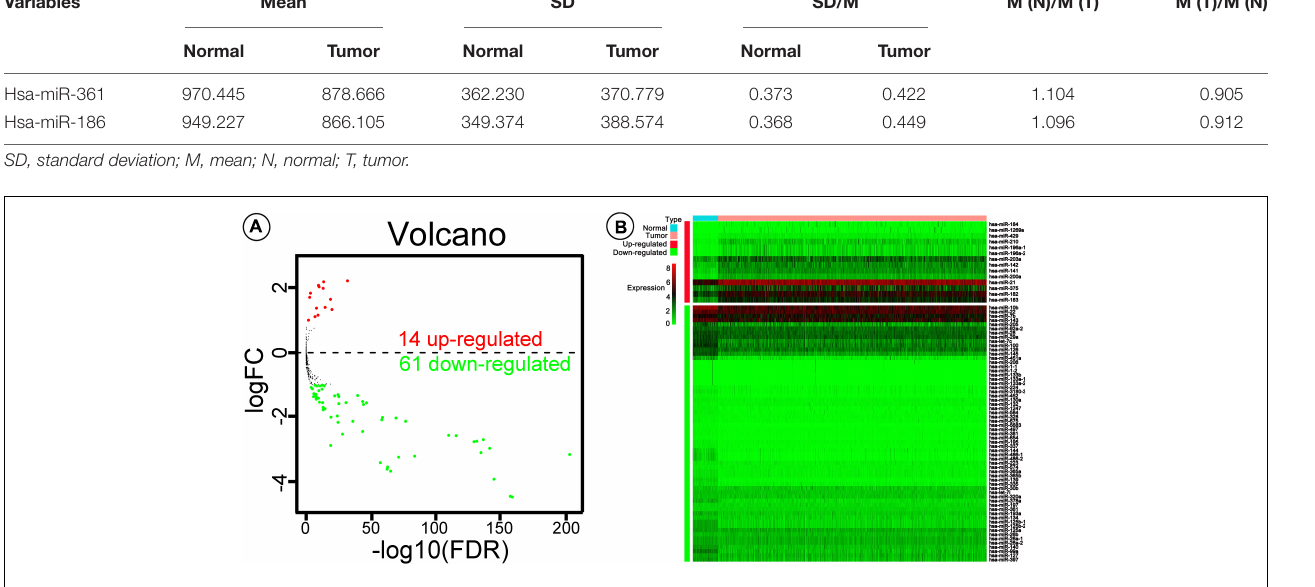
FIGURE 1 | Volcano plot and pheatmap showing differentially expressed microRNAs (miRNAs). (A) Values plotted are mean normalized signal values (log10-scaled) for control ( x -axis) and experimental ( y -axis) groups. Red and green points correspond to twofold-change up/down, respectively ( P < 0.05). (B) The pheatmap R package was used to plot expression levels of the differentially expressed miRNAs in breast cancer (BC) and adjacent tissue; red and green indicate that miRNA was expressed at high or low levels,